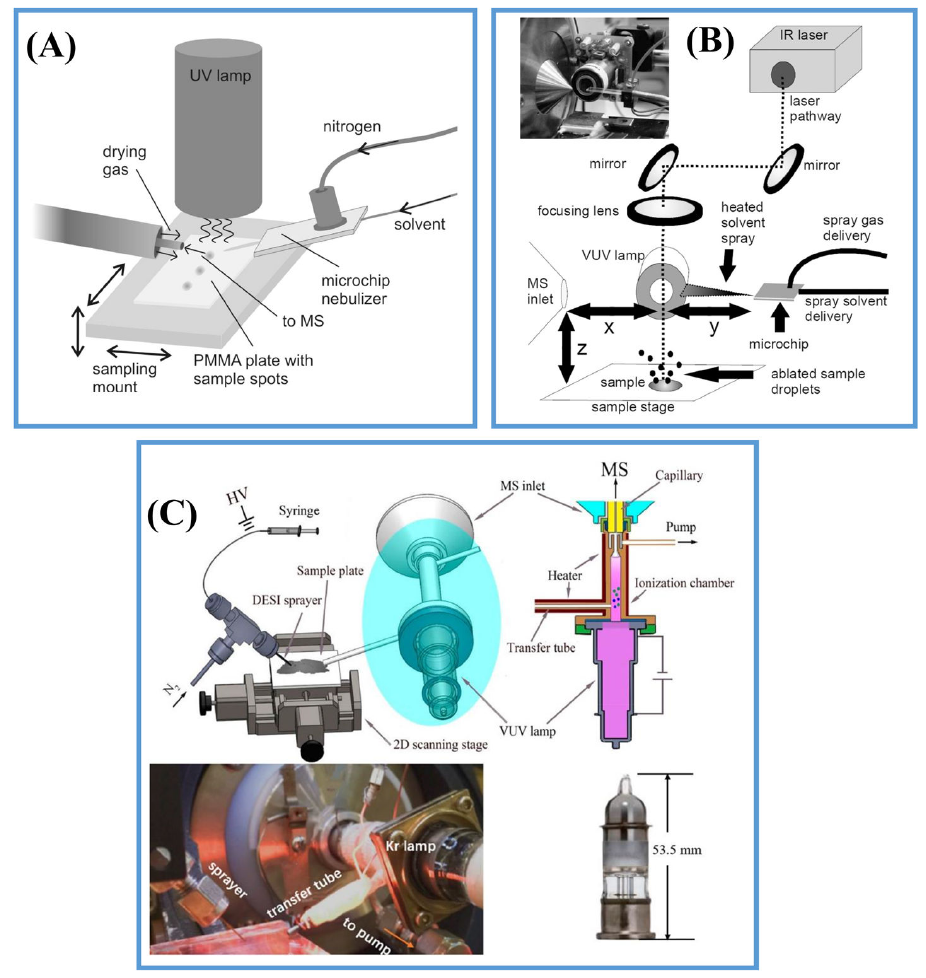
Figure 5. ( A ) Scheme of DAPPI ion source. Reprinted with permission from the authors of [66]. Copyright (2007) American Chemical Society. ( B ) Scheme of LAAPPI ion source. Reprinted with permission from the authors of [69]. Copyright (2012) American Chemical Society. ( C ) Scheme of DESI/PI ion source. Reprinted with permission from the authors of [73]. Copyright (2019) American Chemical